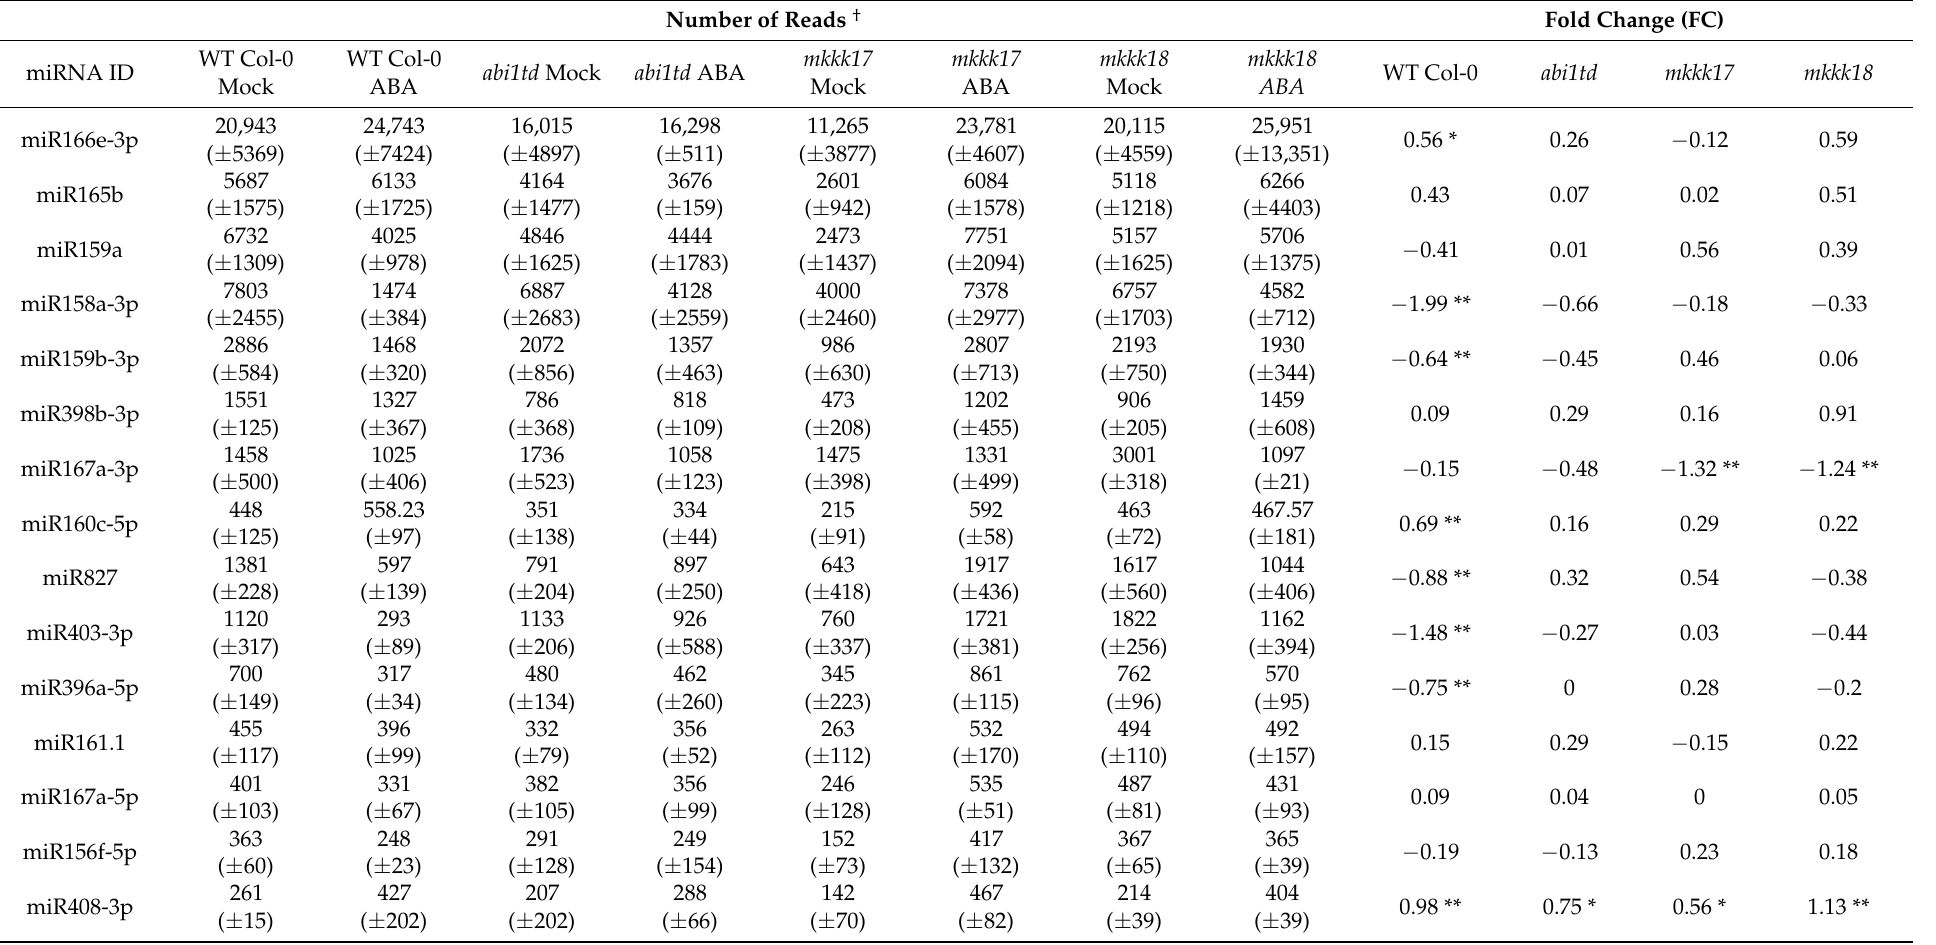
Table 2. Normalized reads of top fifteen expressed miRNAs and their fold change in all genotypes. List of normalized reads of top fifteen expressed miRNAs in mock treatment and 4 h of 100 µ M ABA-induced samples of Arabidopsis thaliana WT Col-0, abi1td , mkkk17 , and mkkk18 mutants in all libraries; each value is the average of three biological replicates of mock treatment and 4 h of 100 µ M ABA-induced libraries. Fold change is from log2 (fold change) in NGS data after 4 h of 100 µ M ABA-induced samples of Arabidopsis thaliana WT Col-0, abi1td , mkkk17 , and mkkk18 mutants; the p -value in NGS data is indicated with * ( p -value ≤ 0.05), ** ( p -value ≤ 0.01). † Values are in reads per million